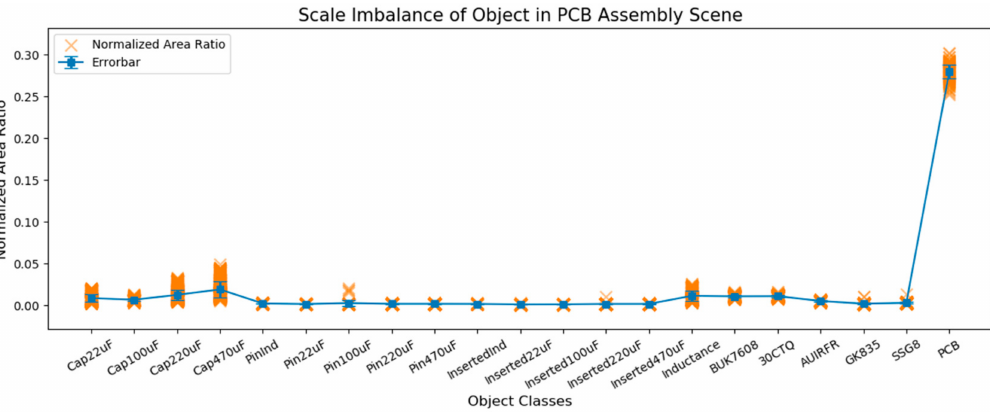
Figure 8. Statistics chart of the normalized area ratio of all